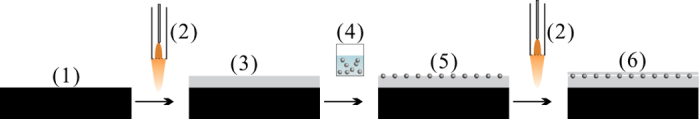
Scheme of the fabrication process.(1)original sample of non-woven PET fabric; (2)plasma jet system for thin film deposition, detail of the experimental setup is given as a supplement information; (3) 1st step: plasma deposition of the reservation layer for silver nanoparticles immobilization and to control the silver nanoparticles adhesion to the PET fibres.; (4) prepared AgNPs dispersion; (5) 2nd step: AgNPs adhesion on the surface of the samples by immersing into the dispersion; (6) 3rd step: plasma deposition of the barrier layer.